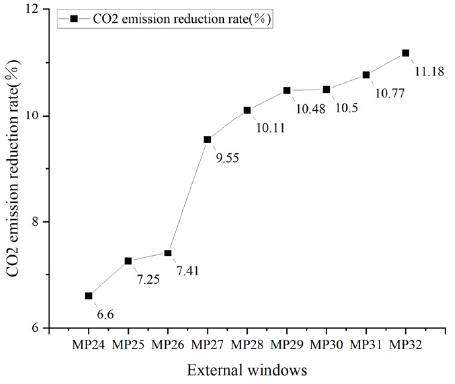
Figure 6. CO 2 emission reduction rate of different window types.